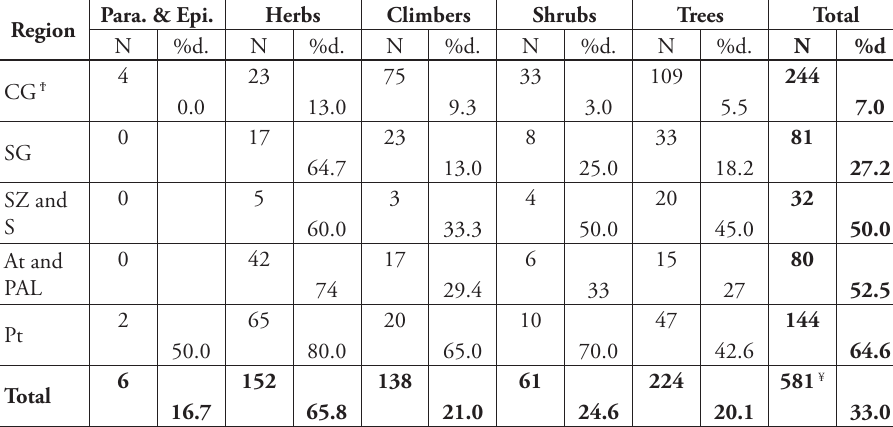
Table 1. Number of species alive and percentage declining (d.) in different ecological zones. Drabo July 2016. Para. & Epi. Herbs Climbers Shrubs Trees Total Region N %d. N %d. N %d. N %d. N %d. N %d 4 23 75 33 CG Ϯ